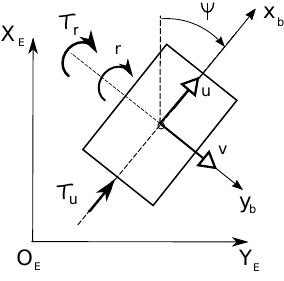
Figure 1. Underwater vehicle model